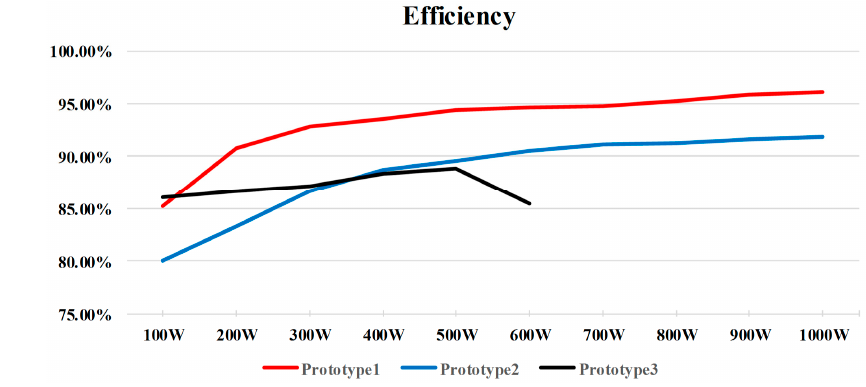
Figure 20. Efficiency comparison.